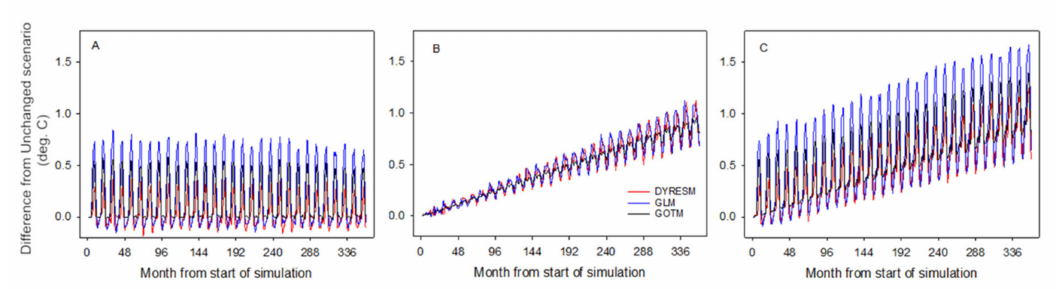
Figure 8. Long-term trend of the 90th percentile of the 0-10 m layer for of all realizations. The values represent the di ff erence between the HW ( A ), LI ( B ) and HW-LI ( C ) scenarios and the Unchanged scenario.